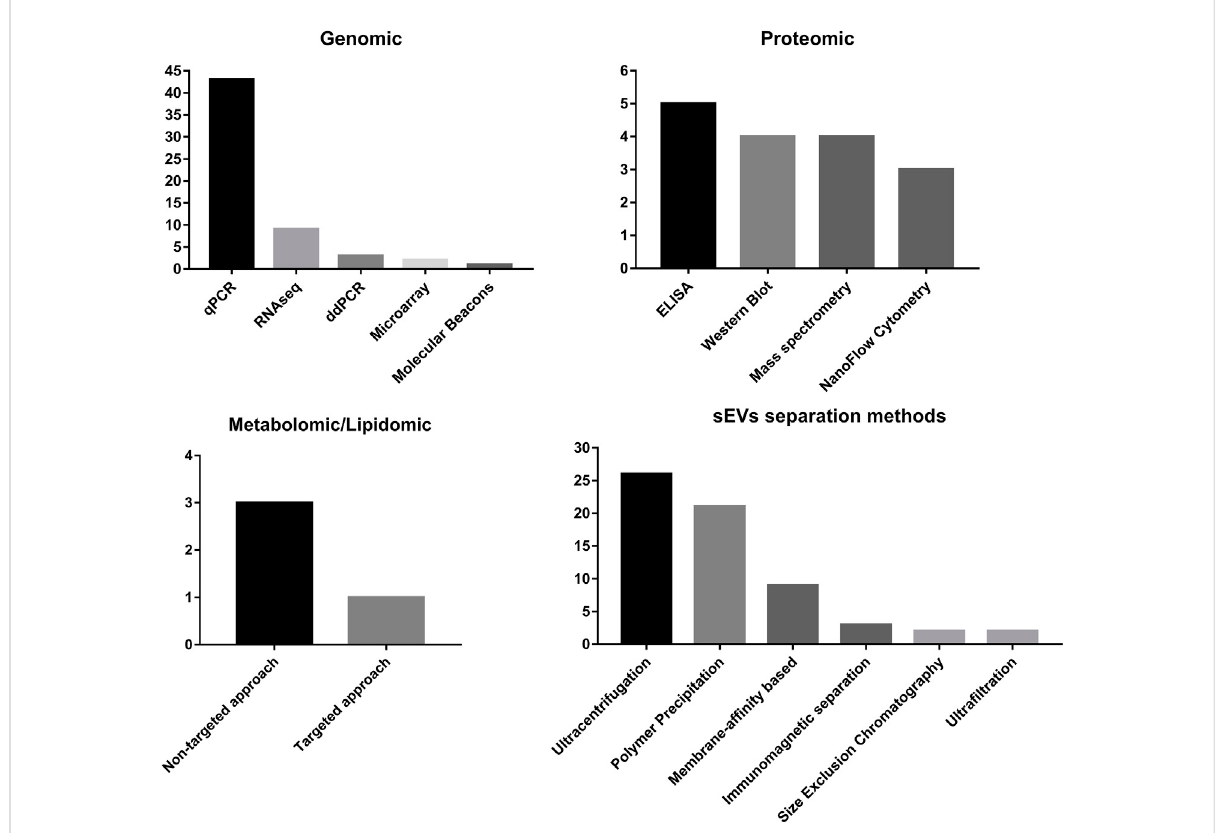
FIGURE 4 Summary of frequency of methods used for sEV separation and methods used for detection of different classes of molecules carried by